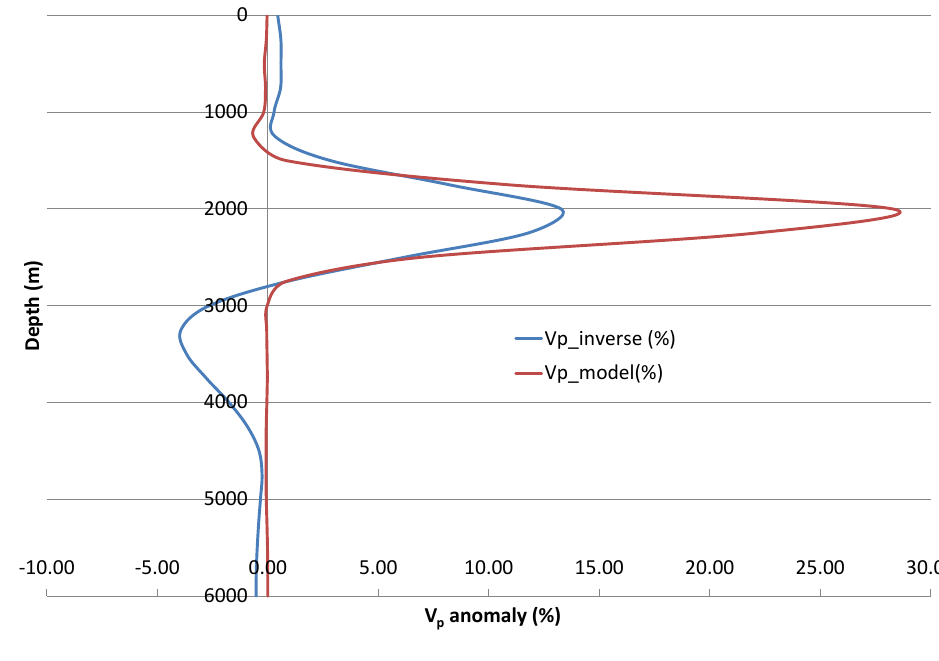
Figure 4. Comparison between checkerboard test model and inversion